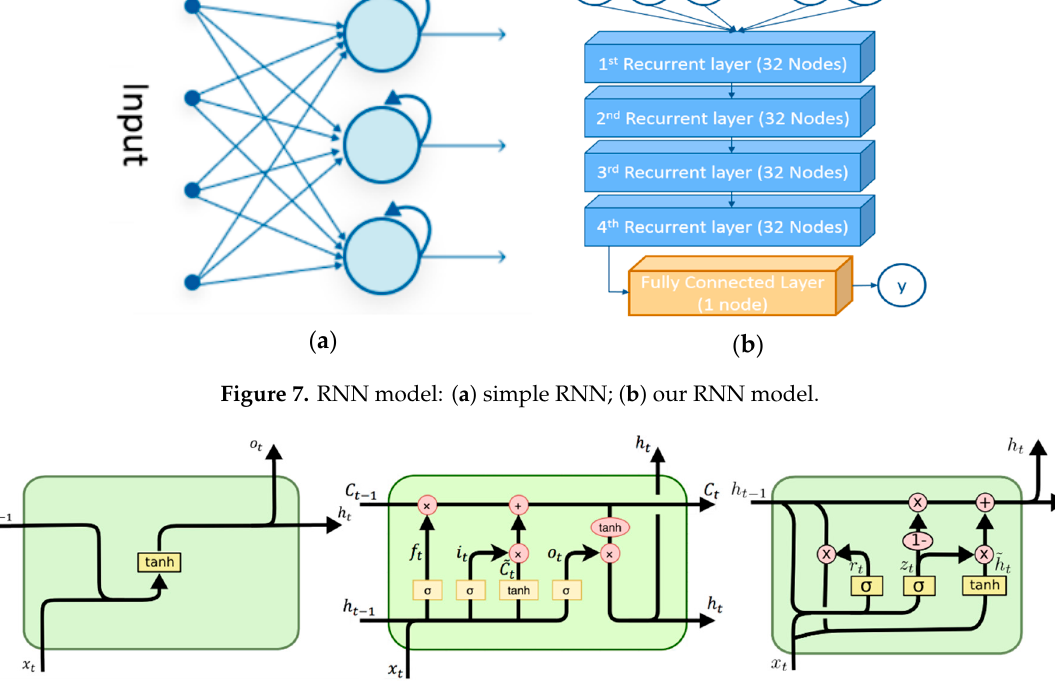
Figure 7. RNN model: ( a ) simple RNN; ( b ) our RNN model.